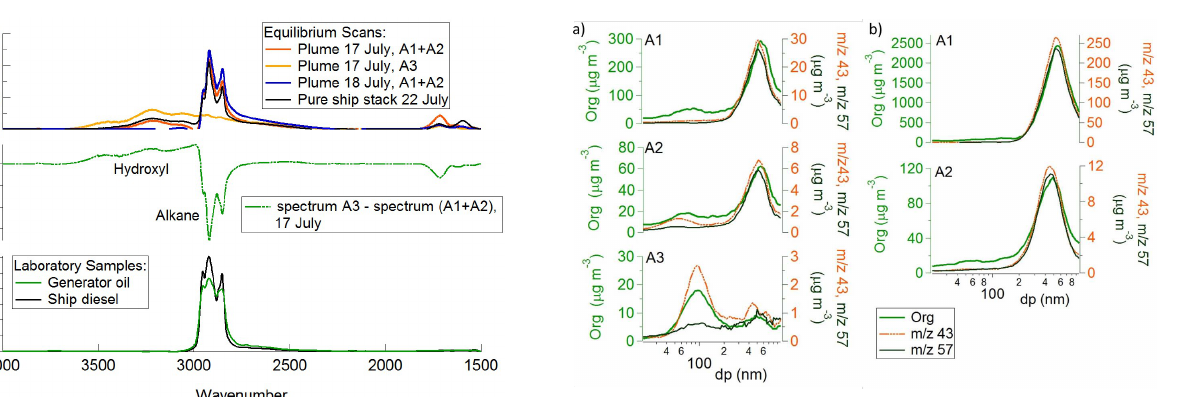
Fig. 7. FTIR spectra of the plume for a filter sample over ages A1 and A2 (“A1 + A2”), and a sample for age A3 (upper panel) and their difference (middle panel). Spectra of the pure ship stack emissions (sampled on 22 July) as well as the smoke oil and the ship diesel fuel are shown for comparison (lower panel). Hydroxyl functional groups are detected in the aged smoke plume, but much less so in the fresh smoke and the laboratory samples.